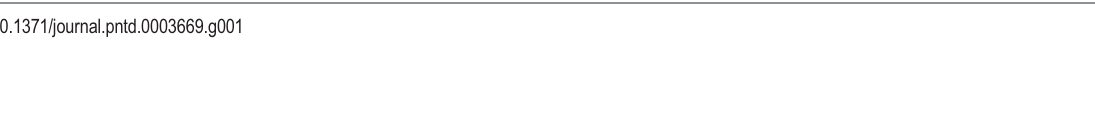
PLOS Neglected Tropical Diseases | DOI:10.1371/journal.pntd.0003669 March 27,